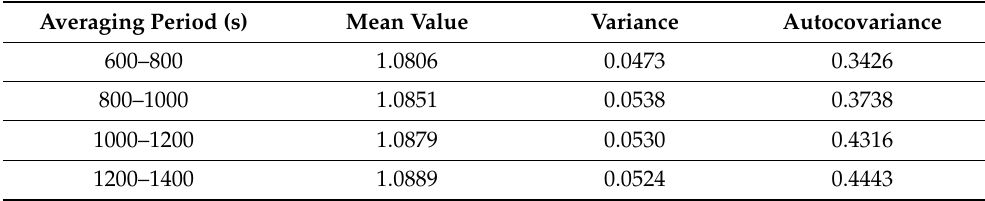
Table 1. Mean Value, Variance and Autocovariance for Specific Time